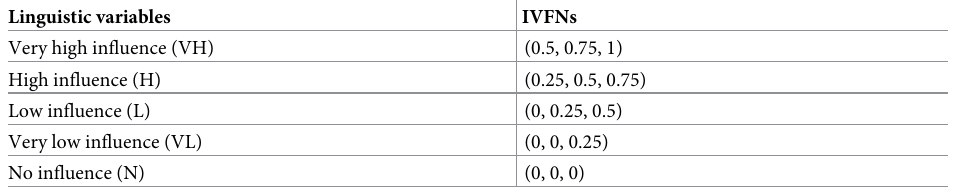
Table 3. The TFNs of linguistic variables for the importance weight of